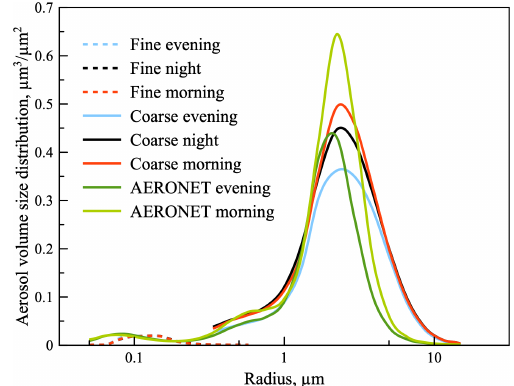
Figure 12. Aerosol volume size distribution for fine (dashed) and coarse (solid) aerosol components retrieved on 15–16 April 2015. Distributions retrieved before and after the advanced lidar observa- tion in a combination with Sun-photometer data are shown in blue, and those retrieved by AERONET are in dark and light green, re-